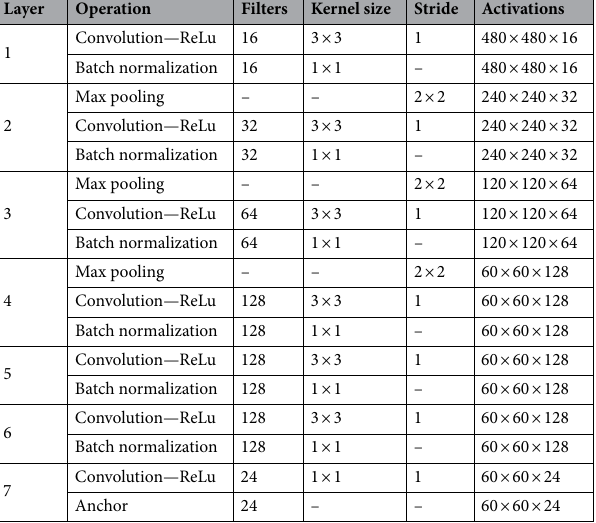
Table 1. YOLOv2 network architecture parameters for zebrafish